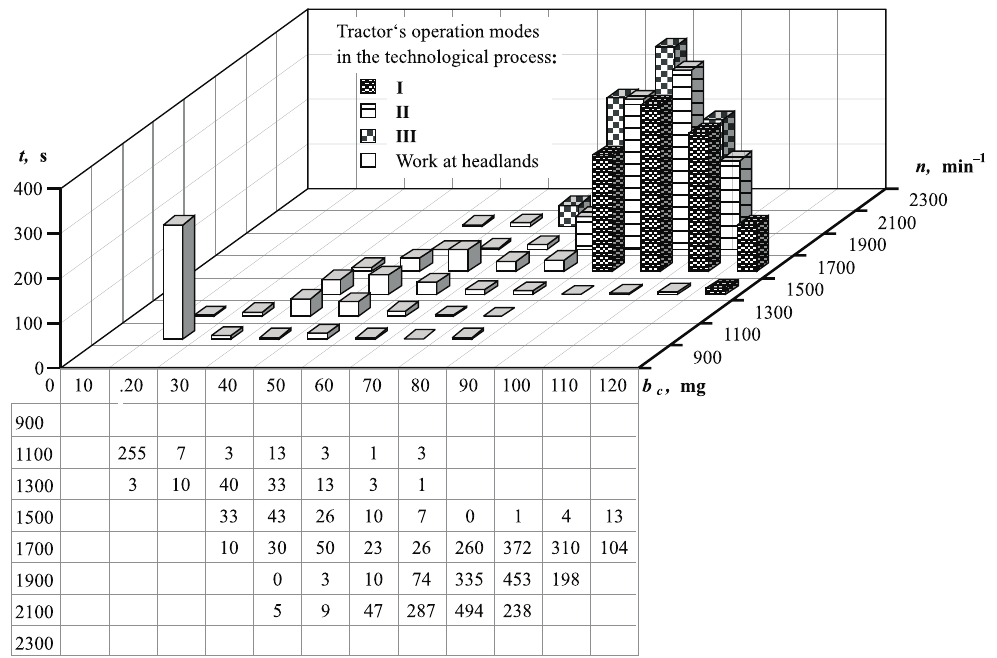
Fig. 6. Distribution of unit’s working time period (3867 s) in the modes of engine speed ( n ) and cyclic fuel ) injection quantity ( b c